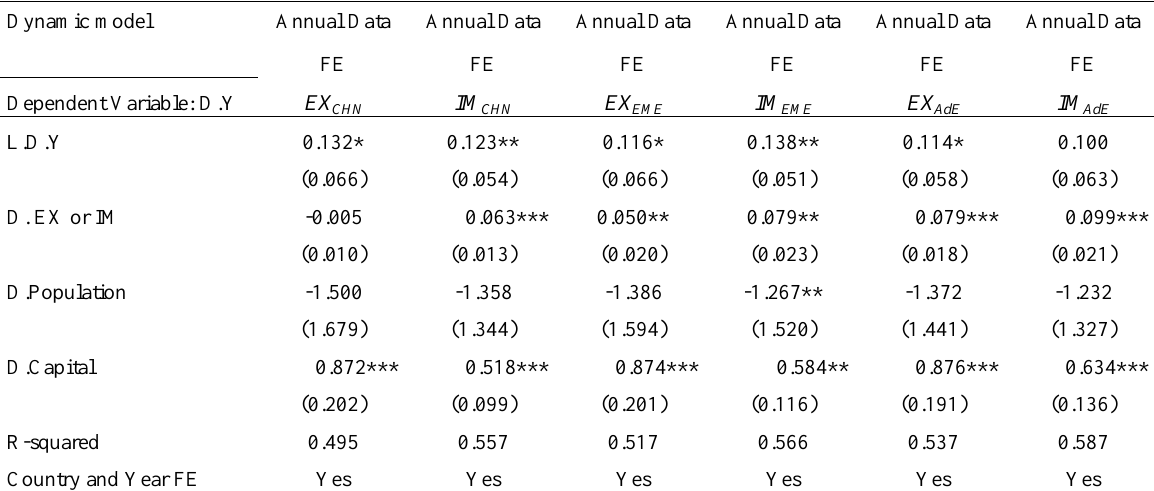
Table 9 : Fixed effects estimation of annual panel